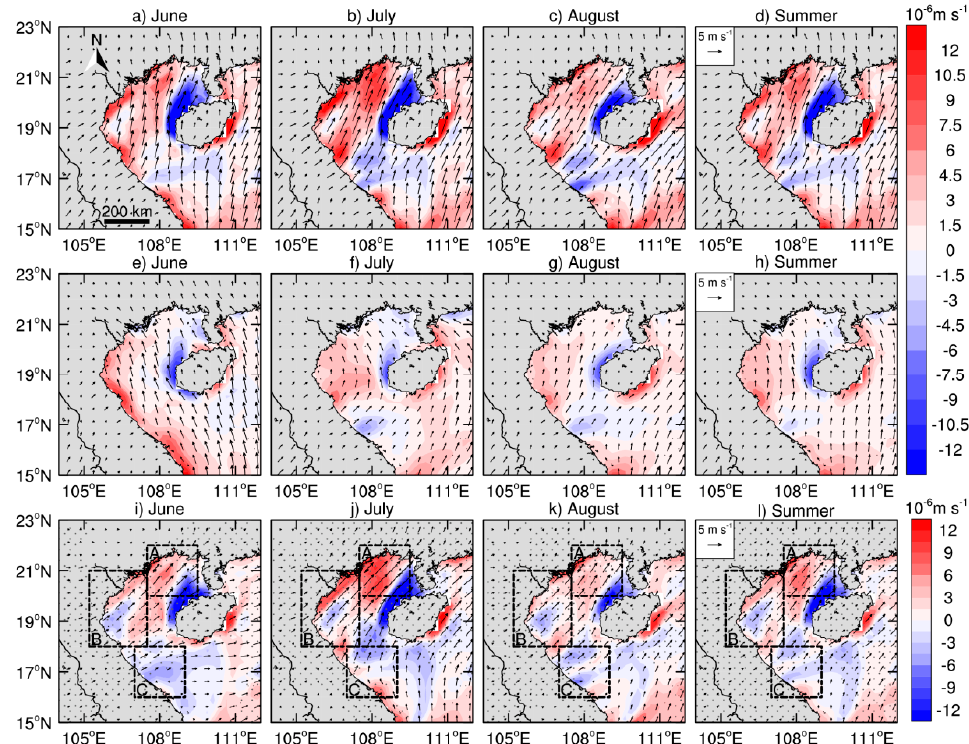
Figure 6. Same as Figure 4 but for the wind field at 10 m (arrows) and the Ekman pumping velocity (shading; positive values represent upwelling).